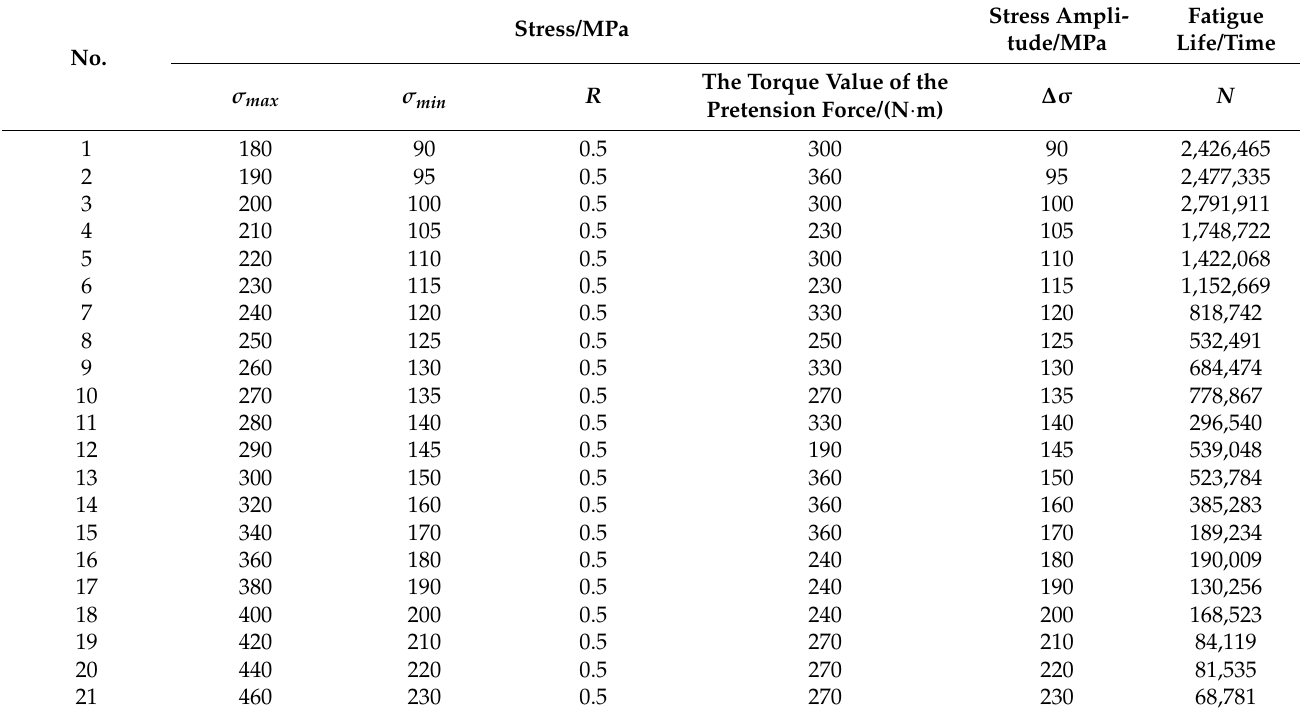
Table 13. Constant amplitude fatigue test data of M24 high-strength bolts with large hexagon